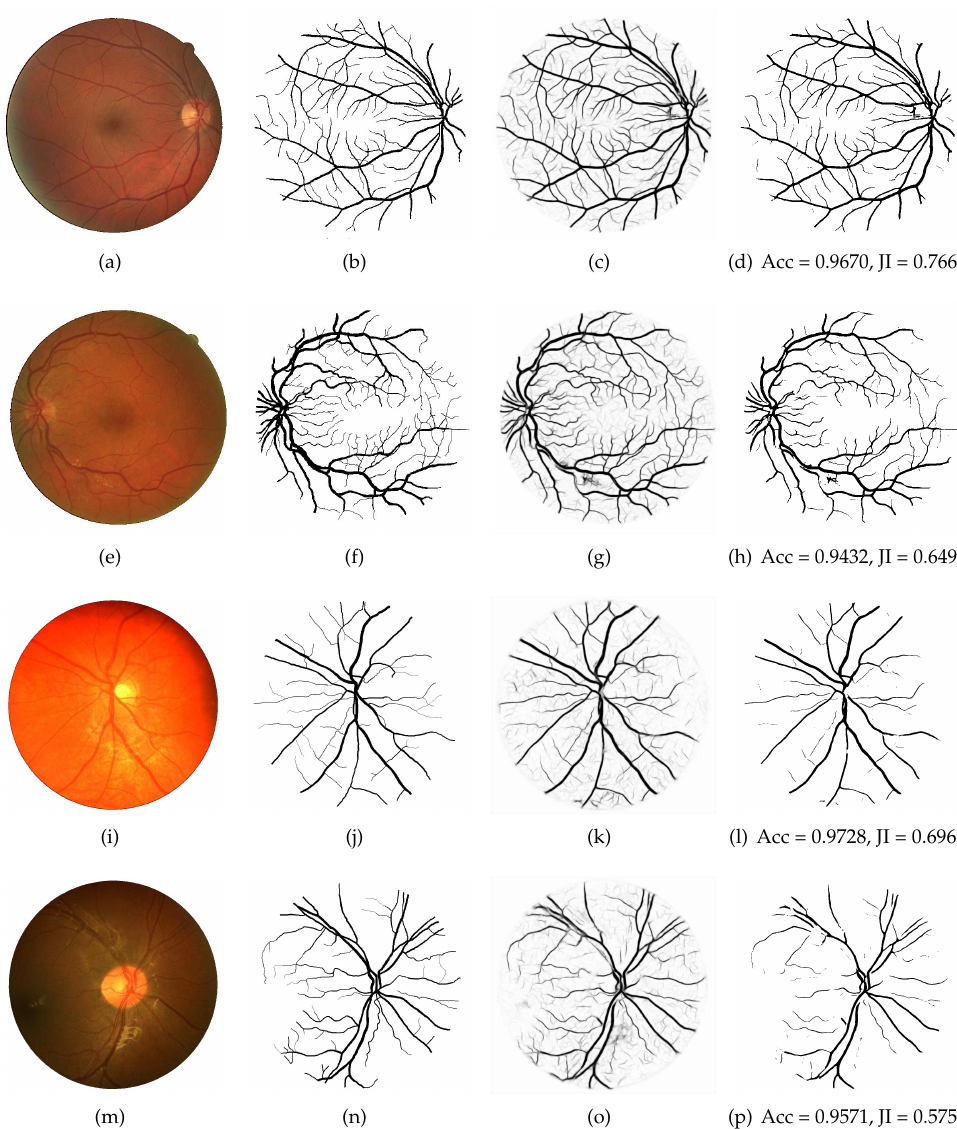
Figure 6. Examples of the best and worst vessel segmentation results by the proposed the LightEyes on images from the DRIVE and CHASE_DB1 datasets. The first and second rows correspond to the highest and lowest accuracy on the DRIVE, and the third and fourth rows correspond to the highest and lowest accuracy on the CHASE_DB1. From column 1 to 4: original fundus images ( a , e , i , m ), ground truth ( b , f , j , n ), probability maps ( c , g , k , o ) and binary maps ( d , h , l , p